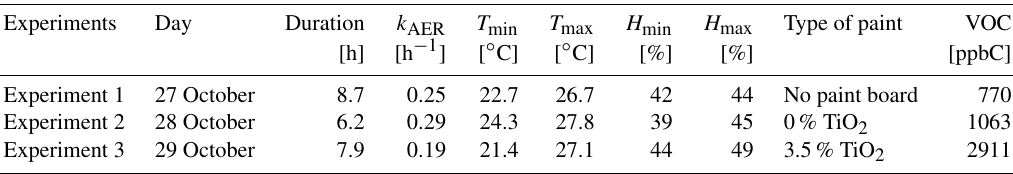
Table 3. Parameters of the experiments: total duration, k AER , minimum and maximum temperature and humidity, type of paint, average total VOC